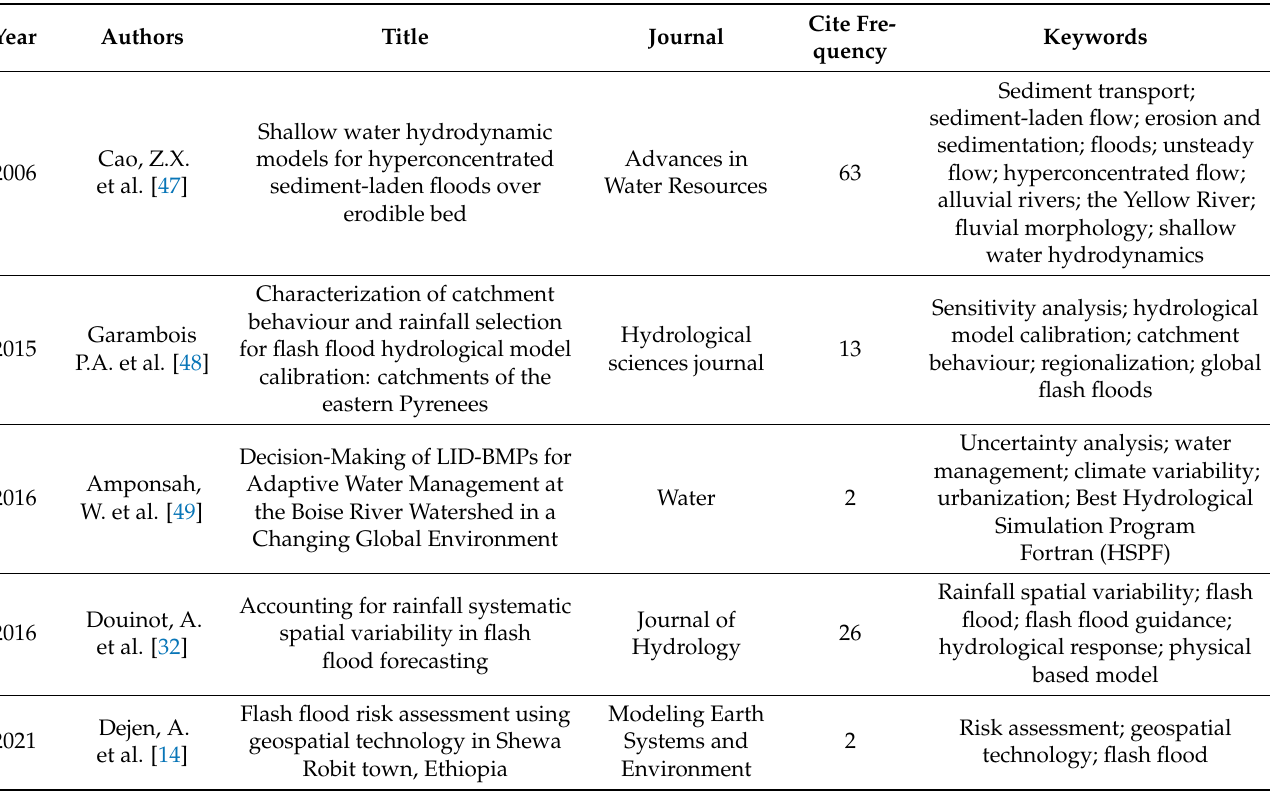
Table 2. Characteristics of the included